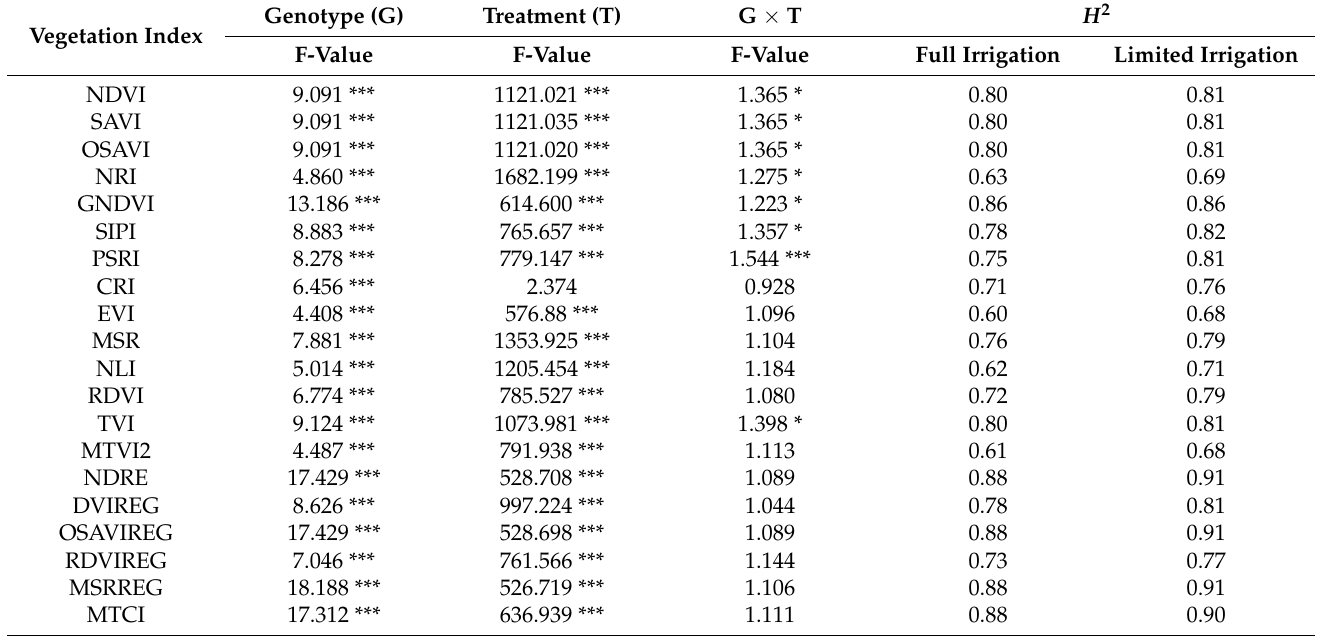
Table A5. Significance test and heritability of the vegetation indexes extracted in the mid-grain filling stage. Vegetation